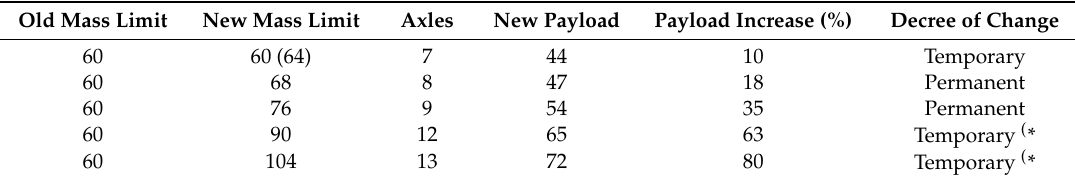
Table 1. Changes in maximum mass (t) and number of axles for vehicle combinations in Finland (adapted from